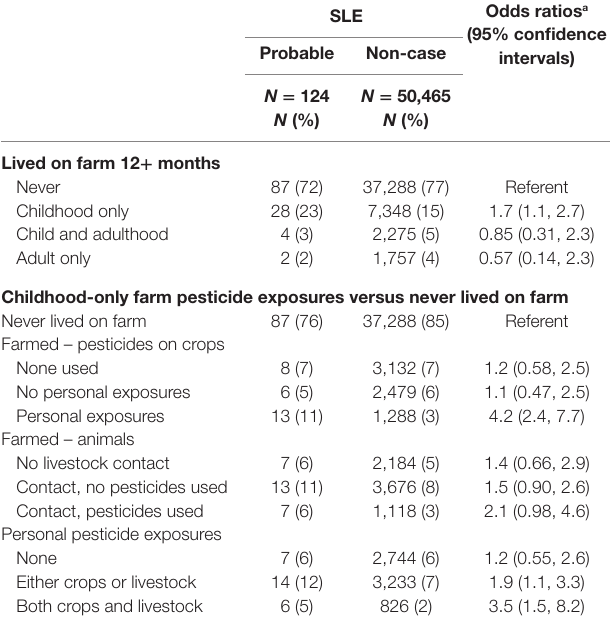
sle Odds ratios a (95% confidence intervals)Probable non-case N = 124 N = 50,465 N (%) N (%)